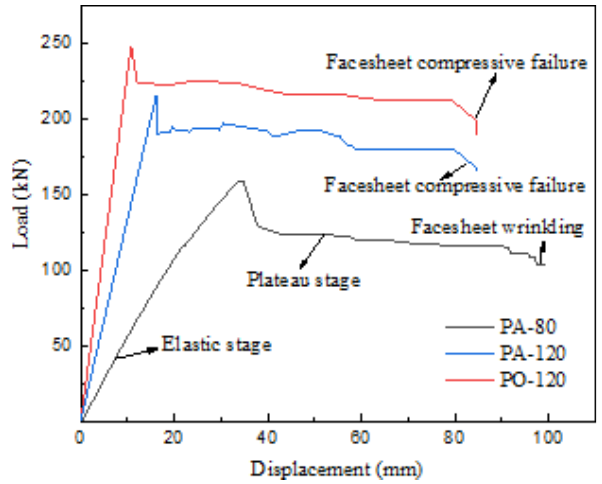
Figure 8: The load-displacement curves of the wood core sandwich panels.